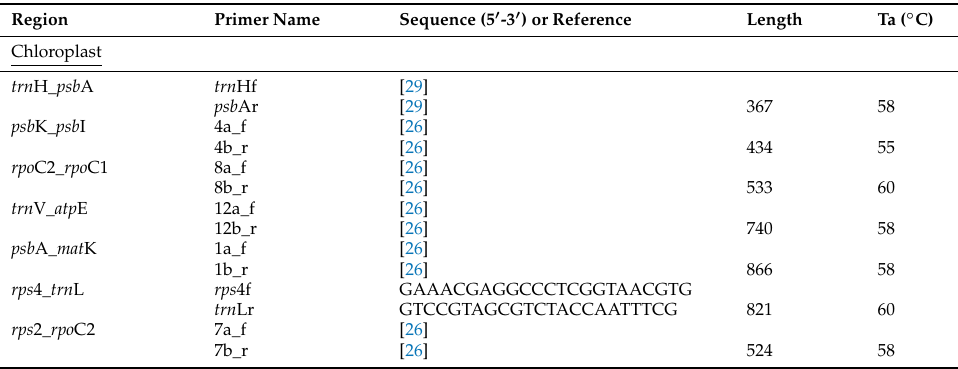
Table 1. Chloroplast (cp) intergenic spacers and investigated nuclear regions. Overview of the primers and PCR conditions for chloroplast and nuclear regions adopted for species differentiation in poplar. The column ‘length’ gives the fragment length in base pairs for P. trichocarpa . Abbreviations in